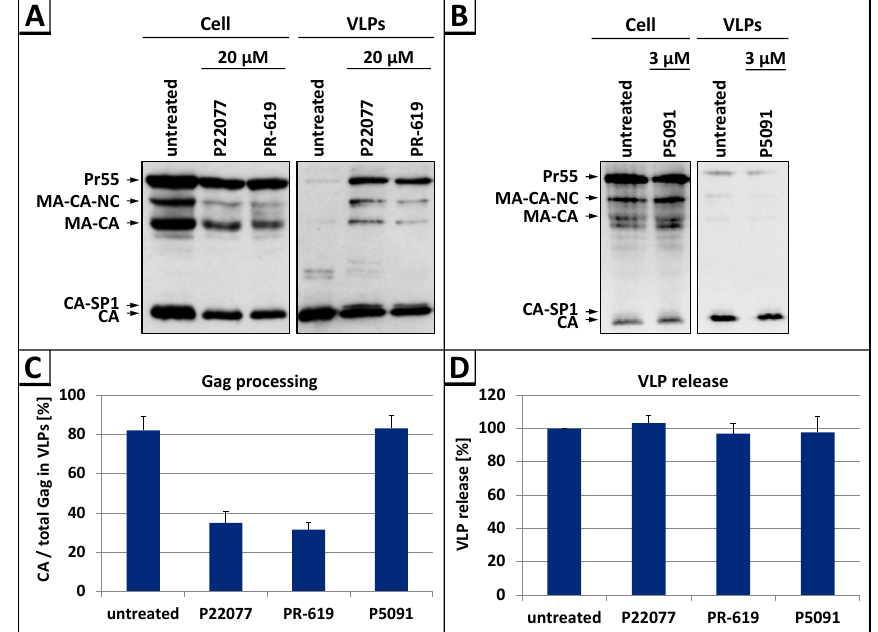
Figure 1. The DUB-inhibitors (DIs) P22077 and PR-619 cause a defect in Gag processing without affecting virus-like particle (VLP) release. ( A , B ) HeLa cells were transiently transfected with the human immunodeficiency virus type 1 (HIV-1) expression plasmid pNL env 1. Twenty-four hours post transfection cells were treated with 20 μM P22077, 20 μM PR-619, or 3 μM P5091 for 6 h. Whole cell lysates and VLP fractions were analyzed by western blotting using an anti-capsid (CA) antibody; ( C ) Rate of Gag processing was calculated as the amount of p24 relative to the total amount of Gag in each VLP fraction. Bars represent mean values of 4 independent experiments ± SD; ( D ) The VLP release was calculated as the amount of CA in the VLP fraction relative to the total amount of Gag detected in cell and VLP fractions. Values on the y -axis were adjusted to 100% for the untreated control. Bars represent mean values of 4 independent experiments ± SD.